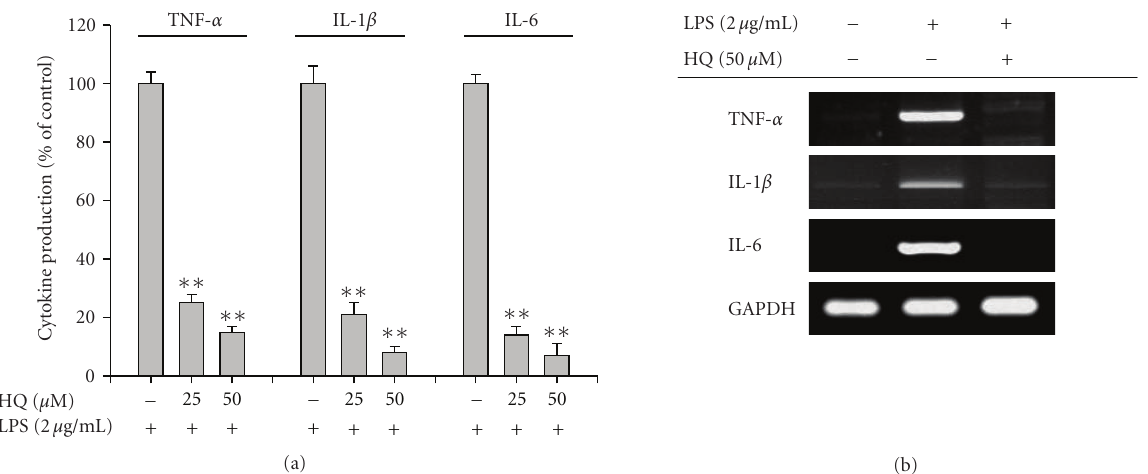
Figure 2: E ff ect of hydroquinone on the production of cytokines and their mRNA expression in LPS-activated RAW264.7 cells. (a) RAW264.7 cells (2 × 10 6 cells/mL) were incubated with indicated concentrations of HQ (hydroquinone) in the presence or absence of LPS (2 μ g/mL) for 12 hours. Secreted levels of TNF- α , IL-1 β , and IL-6 in culture supernatant were determined by ELISA. (b) The mRNA levels of proinflammatory cytokines from the RAW264.7 cells were determined by semiquantitative RT-PCR. The results show one representative experiment of three. ∗ p < . 05 and ∗∗ p < . 01 represent significant di ff erence as compared to control.